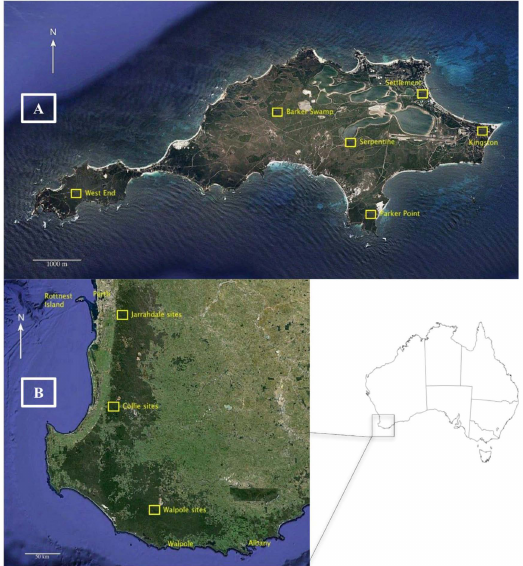
Figure 1. Map of Rottnest Island ( A ) and the mainland ( B ) with the locations where quokkas were trapped. Map data © 2016 Google, Data, Stripss Institute of Oceanography (SIO), National Oceanic and Atmospheric Administration (NOOA), U.S. Navy, National Geospatial Intelligence Agency (NGA), General Bathymetric Chart of the Oceans